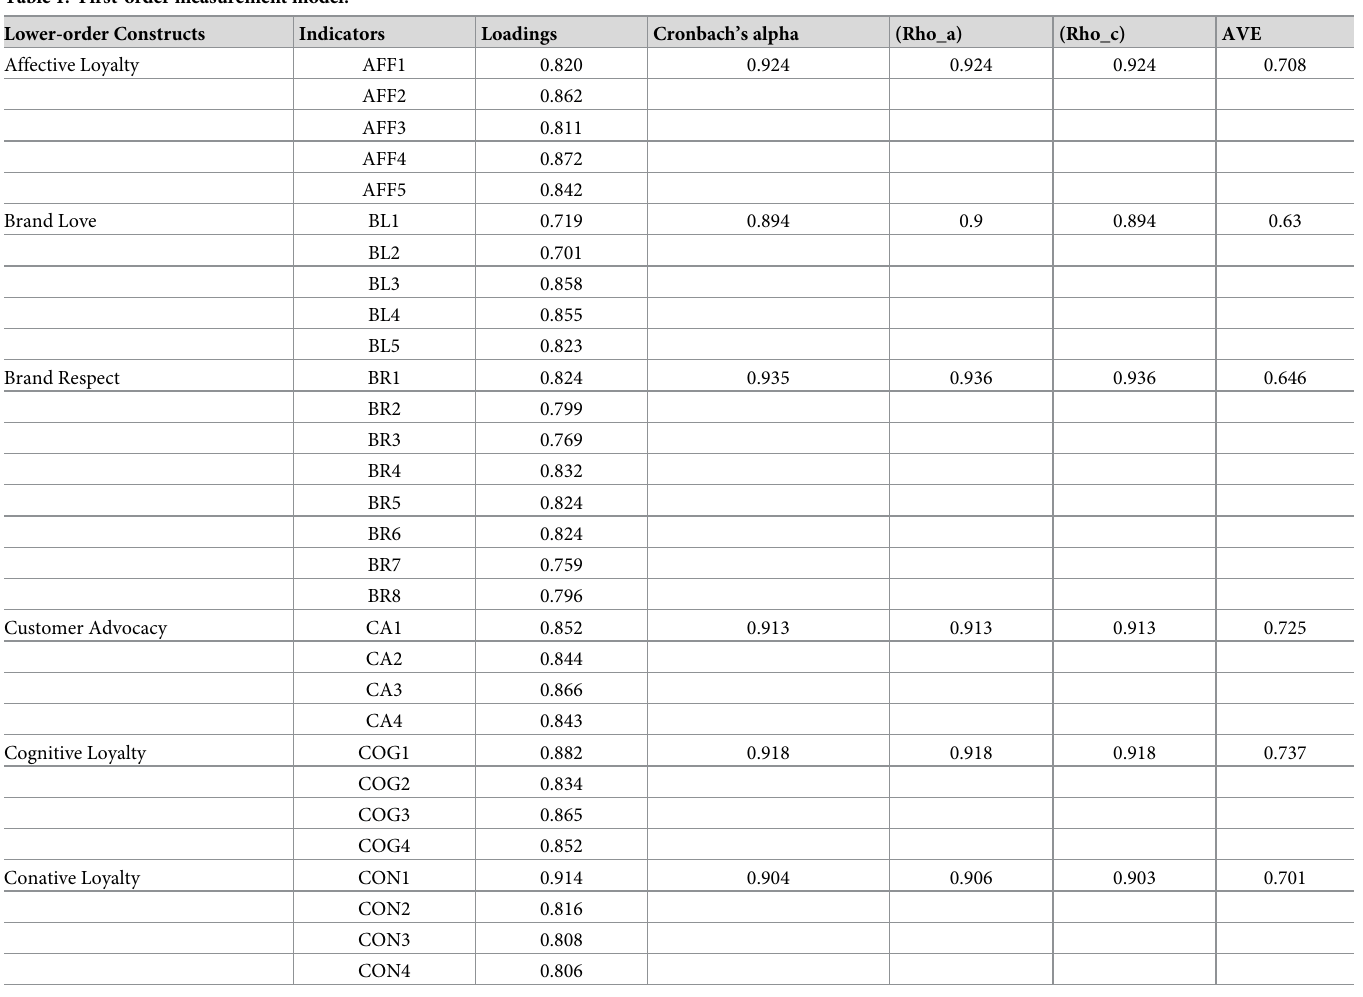
Table 1. First-order measurement model.